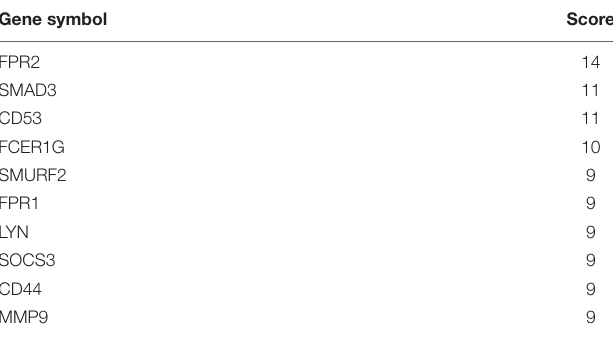
TABLE 2 | The top 10 scores of hub